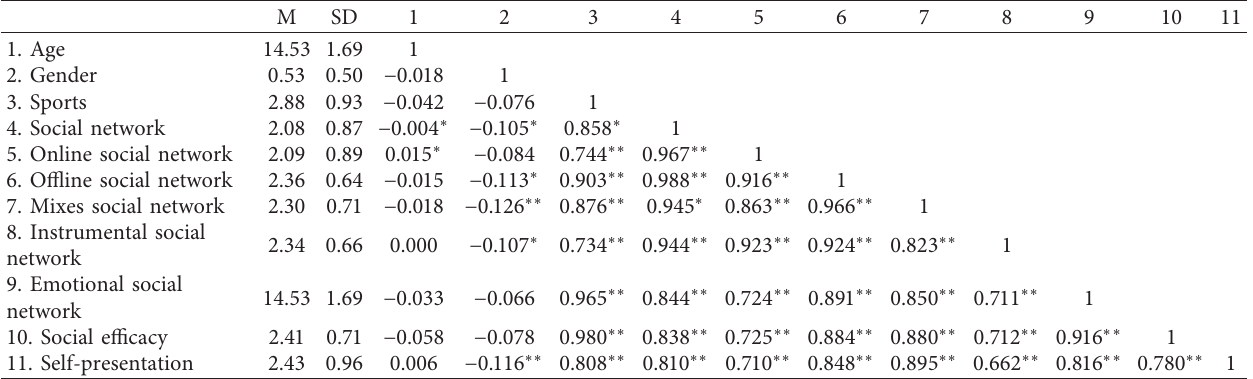
Figure 1: Scree plot of adolescent sports (a) and social network (b). Table 1: Mean, standard deviation, and correlation coefficient of